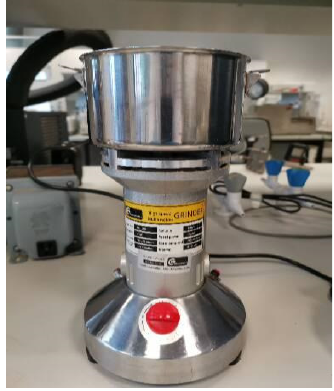
Figure 6. High speed grinder.